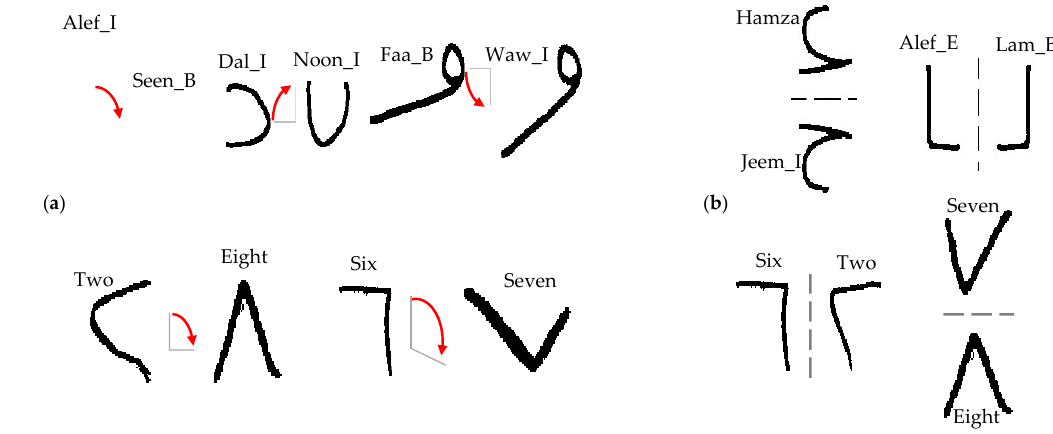
Figure 4. Arabic characters and digits that can be badly affected by rotation and flipping ( a ) Confusion caused by rotation effect; ( b ) Confusion caused by flipping.